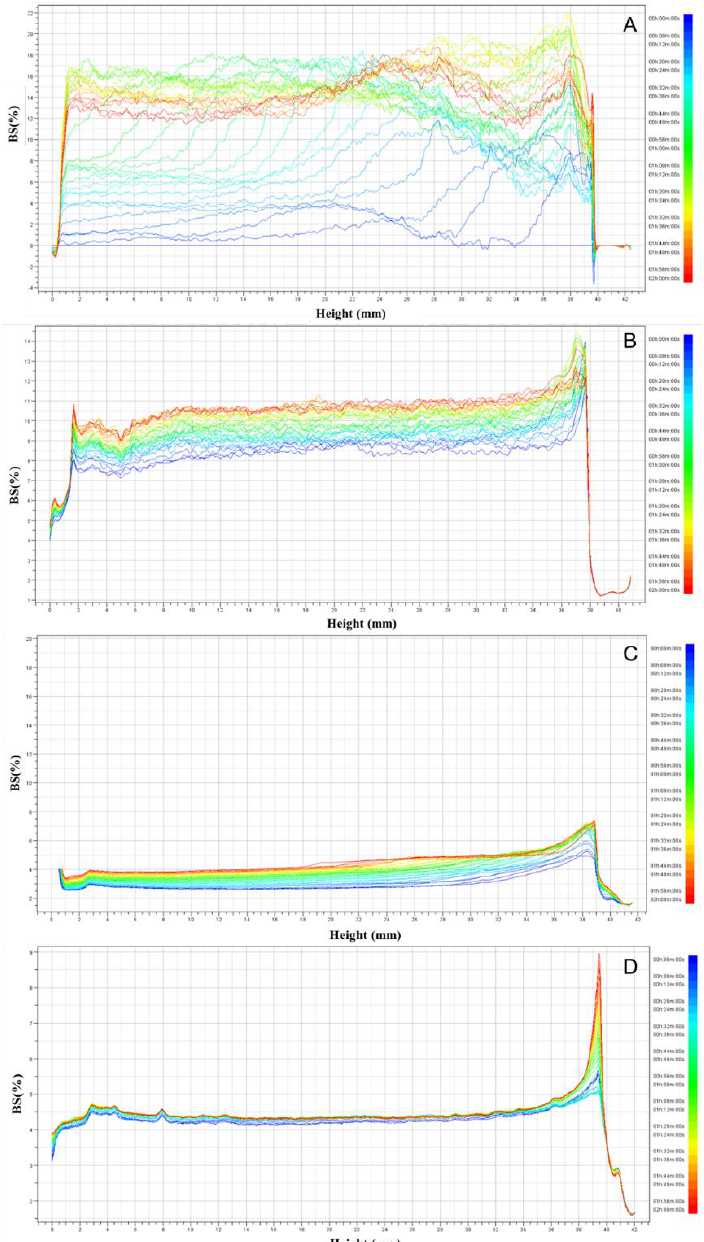
Figure 4. Backscattering (BS) profiles of peanut proteins obtained through different modification methods as a function of the tube height with storage time: ( A ): peanut protein (PP); ( B ): high pressure homogenized protein (HPH); ( C ): high pressure homogenized and enzyme treated protein (HPH-E); ( D ): HPH-E-hydrothermally cooked (HPH-E-HTC) protein.